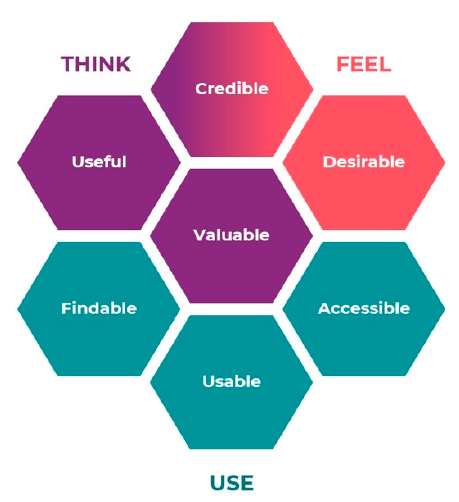
Figure 2. The Optimized Honeycomb model by Karagianni, 2016, used as the categorization matrix for the deductive analysis phase in this study. (Reprinted with permission from the creators).